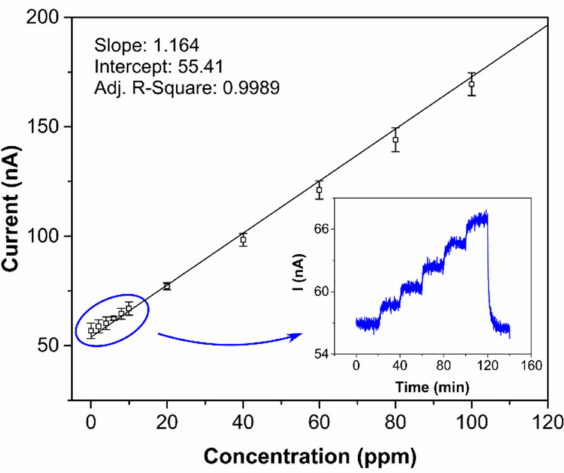
Figure 7. Calibration curve for the sensor with semi-planar topology and aerosol-jet printed compact Au electrode (5 layers); each point represents a mean value of 3 repeated exposures with correspond- ing 95% confidence interval; inset: current-time record within the range 0–10 ppm in steps of 2 ppm. Conditions: 22 ◦ C, 40%RH, 101.325 kPa, 1